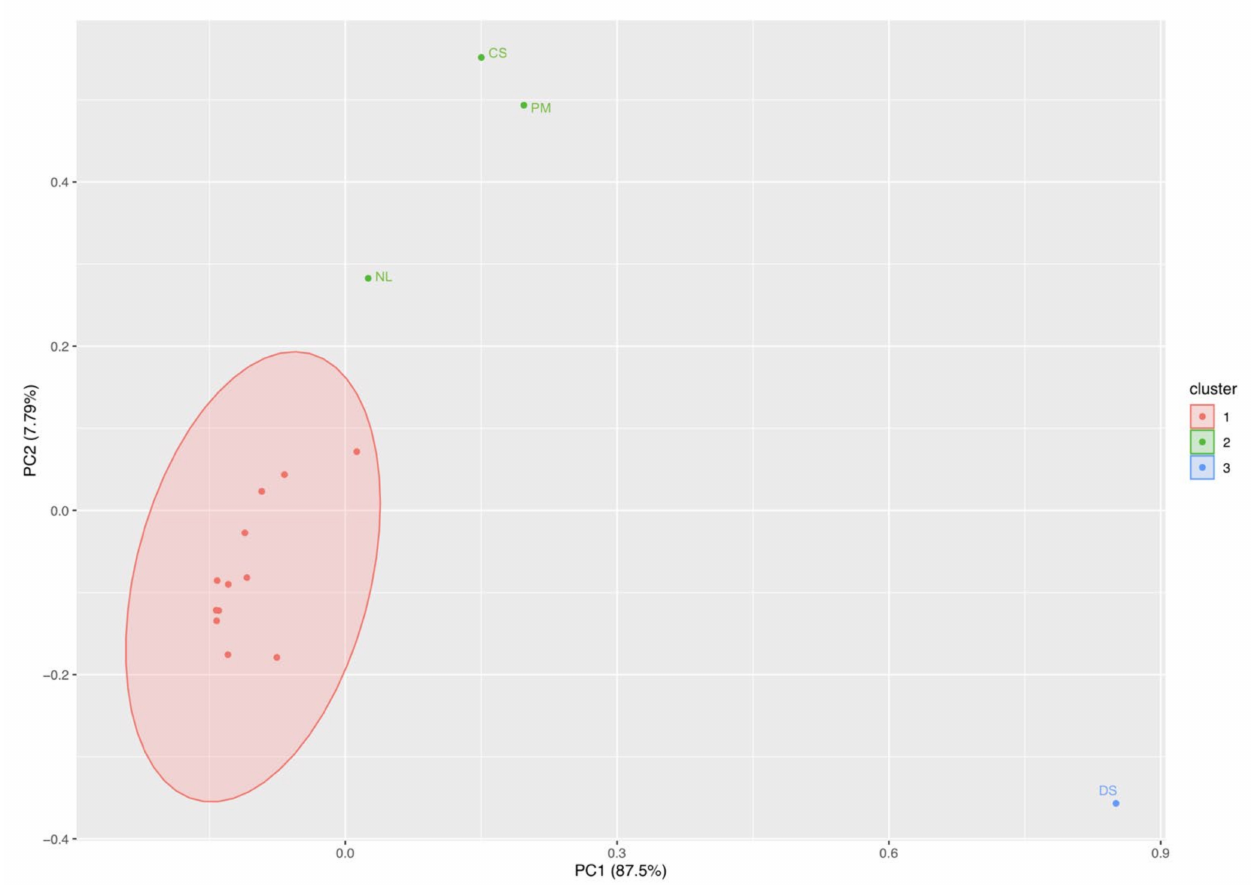
Figure 8. Principal component analysis of brackish water phytoplankton abundance. The main cluster (red) contains the majority of the species that were similar in abundance across treatments (Cr 2 O 7 and ZnO). The red cluster contains only three species: Cocconeis scutellum –CS, Nitzschia liebetruthii–NL, and Prorocentrum micans –PM. The blue cluster contains Dinophysis sacculus